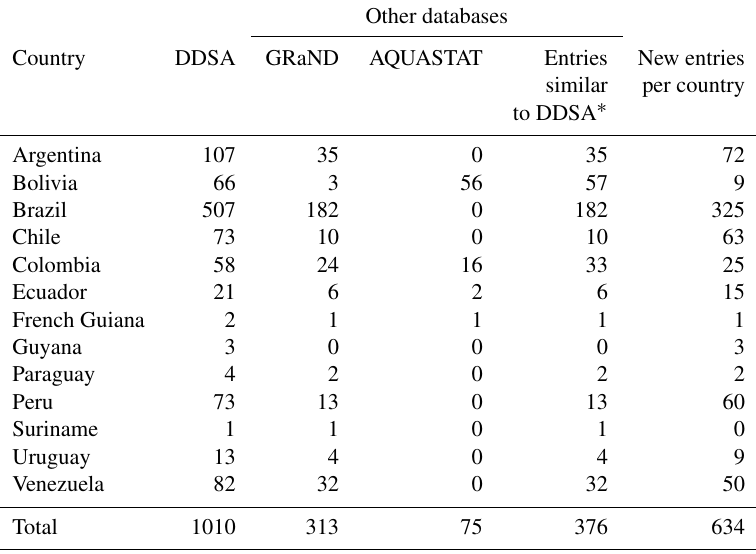
Table 2. Number of new dam entries per country.